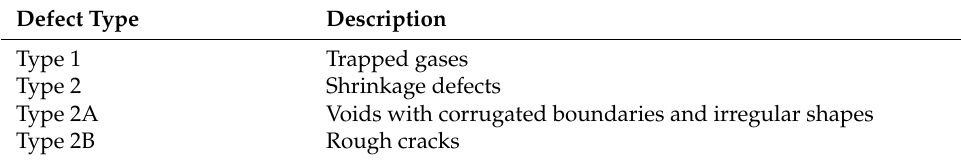
Table 3. Types of defects observed in resin-impregnated micromodels.